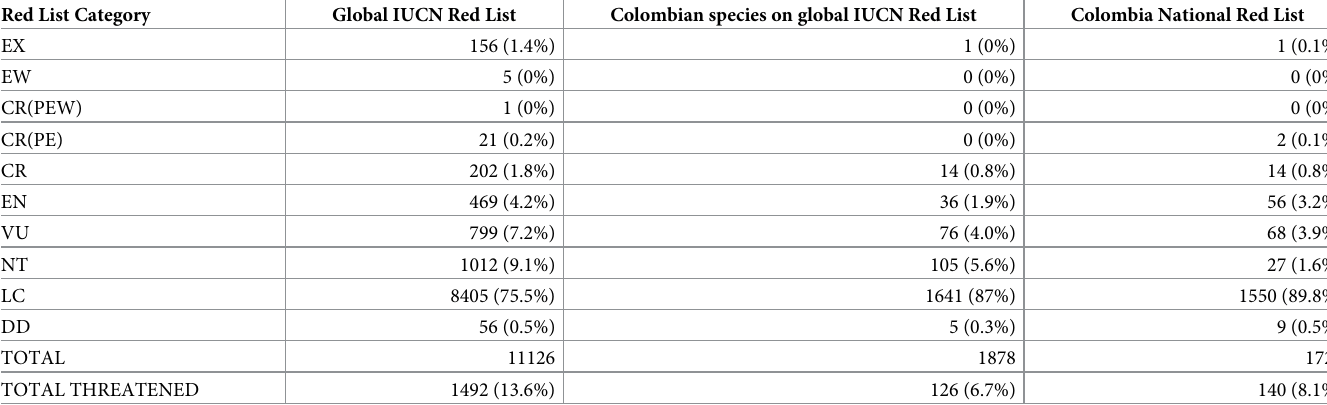
Table 1. Bird species (percentage in parenthesis) in each IUCN Red List category in the world and in Colombia. For Colombia, we excluded vagrants, passage migrants, introduced species, and species of uncertain occurrence. The percentage of threatened species was calculated in relation to the total number of extant species. EX: extinct, EW: extinct in the wild, CR(PEW): critically endangered (possibly extinct in the wild), CR(PE): critically endangered (possibly extinct), CR: critically endan- gered, EN: endangered, VU: vulnerable, NT: near threatened, LC: least concern, DD: data deficient. Global totals are based on the 2018 IUCN Red List. Totals for Colom- bian species on the global IUCN Red List include passage migrants.